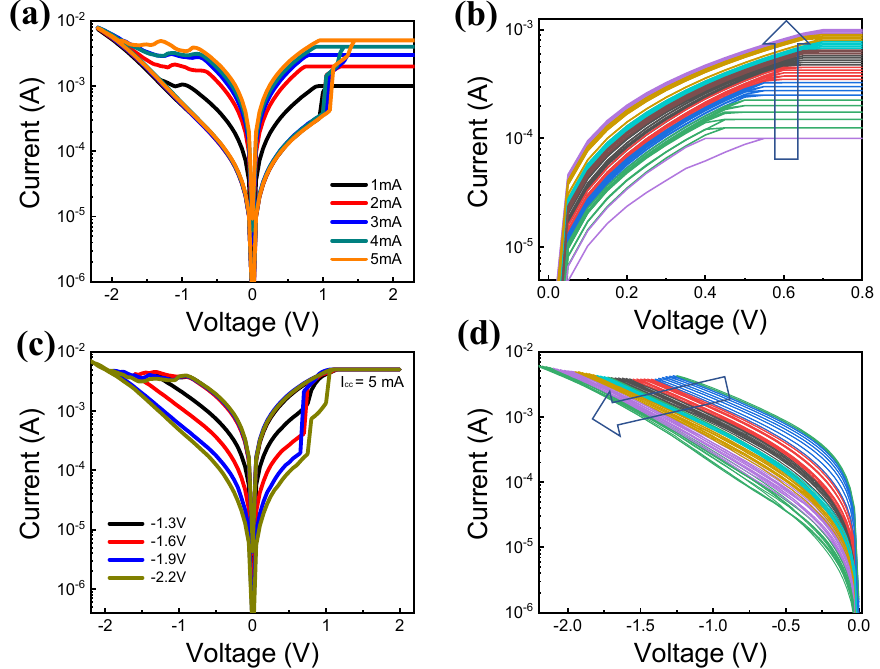
Figure 4. ( a ) I-V curves by controlling compliance current (1 mA, 2 mA, 3 mA, 4 mA, and 5 mA) and ( b ) MLC set process by increasing compliance current. ( c ) I-V curves by reset stop voltage ( − 1.3 V, − 1.6 V, − 1.9 V, and − 2.2 V) and ( d ) MLC reset process by fine control of reset voltage.